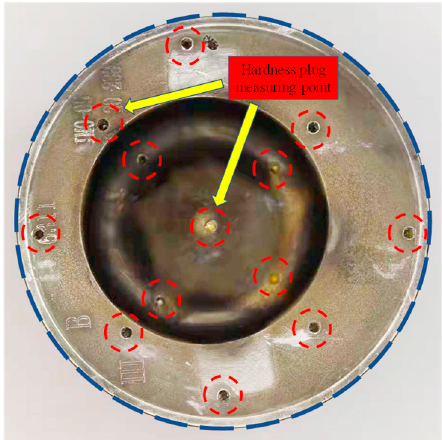
Figure 8. Distribution of temperature field reference points on conventional piston.